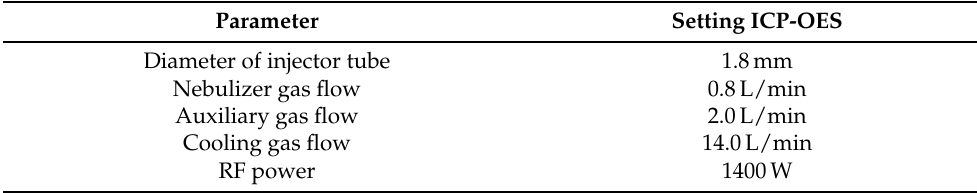
Table 2. Operation settings for the performed ICP-OES analyses of fresh and aged cell components.